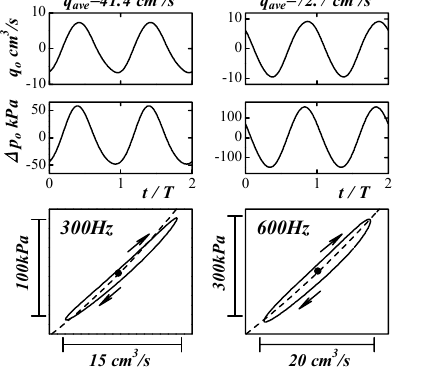
Fig.8 Unsteady relationship between pressure Fig.9 Dependency of orifice impedance drop across and flow rate through orifice on flow rate amplitude in pulsating in pulsating oil flow with average flow rate oil flow with average flow